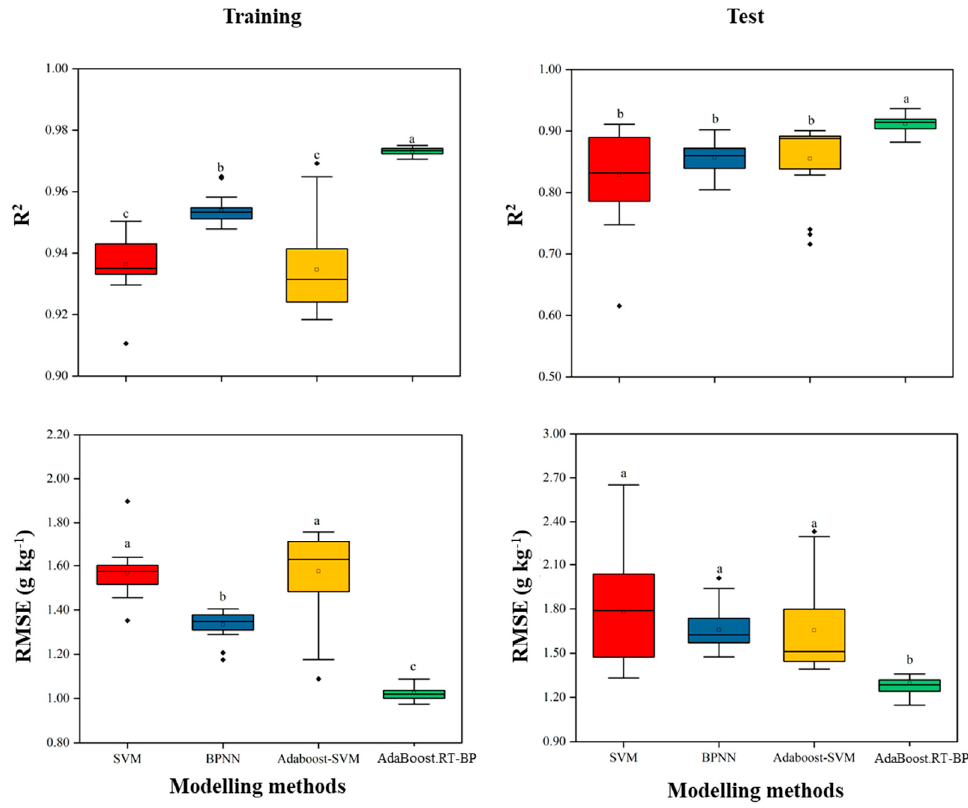
Figure 3. Modelling results of twenty times robust tests by four methods. Adaboost combined with NN outperformed the other modelling methods on the robustness testing. R 2 is the coefficient of determination of training and test, respectively; RMSE is the root mean relative error.